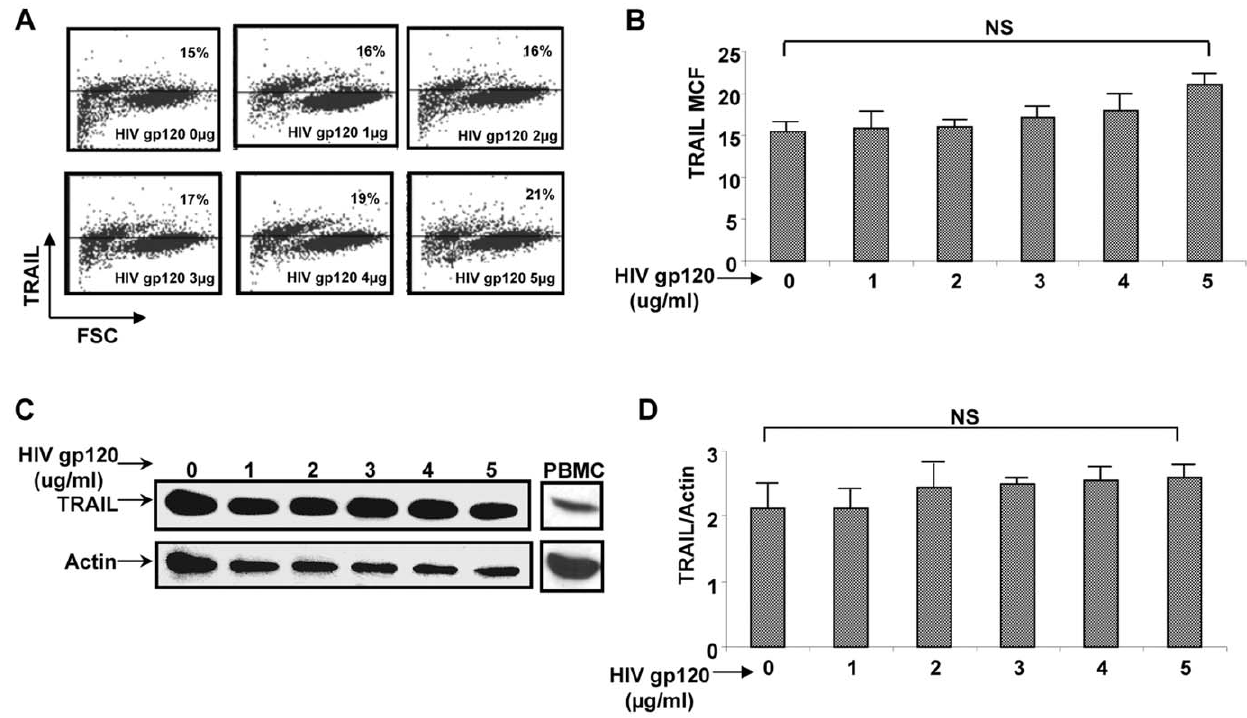
Figure 2. HIV gp120 Does not Increase TRAIL. (A and B) Huh7 cells were incubated with increasing concentrations of HIV gp120 and analyzed for TRAIL expression by Flow cytometry (C and D) and Western